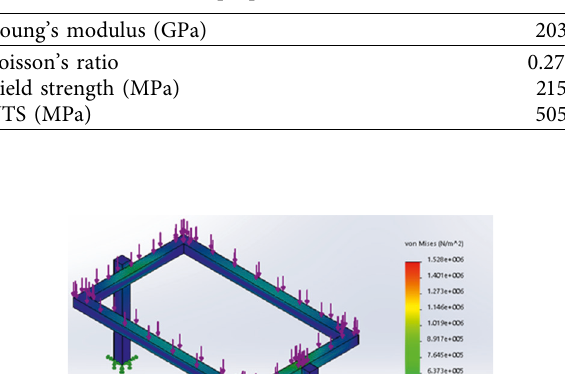
Table 1: Material properties of Stainless Steel 304.